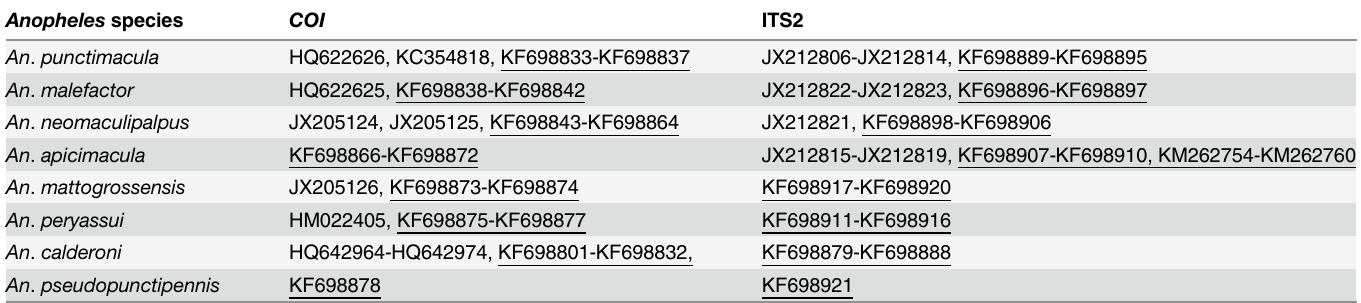
Table 2. Species and GenBank accession numbers of COI and ITS2 sequences used in the phylogenetic